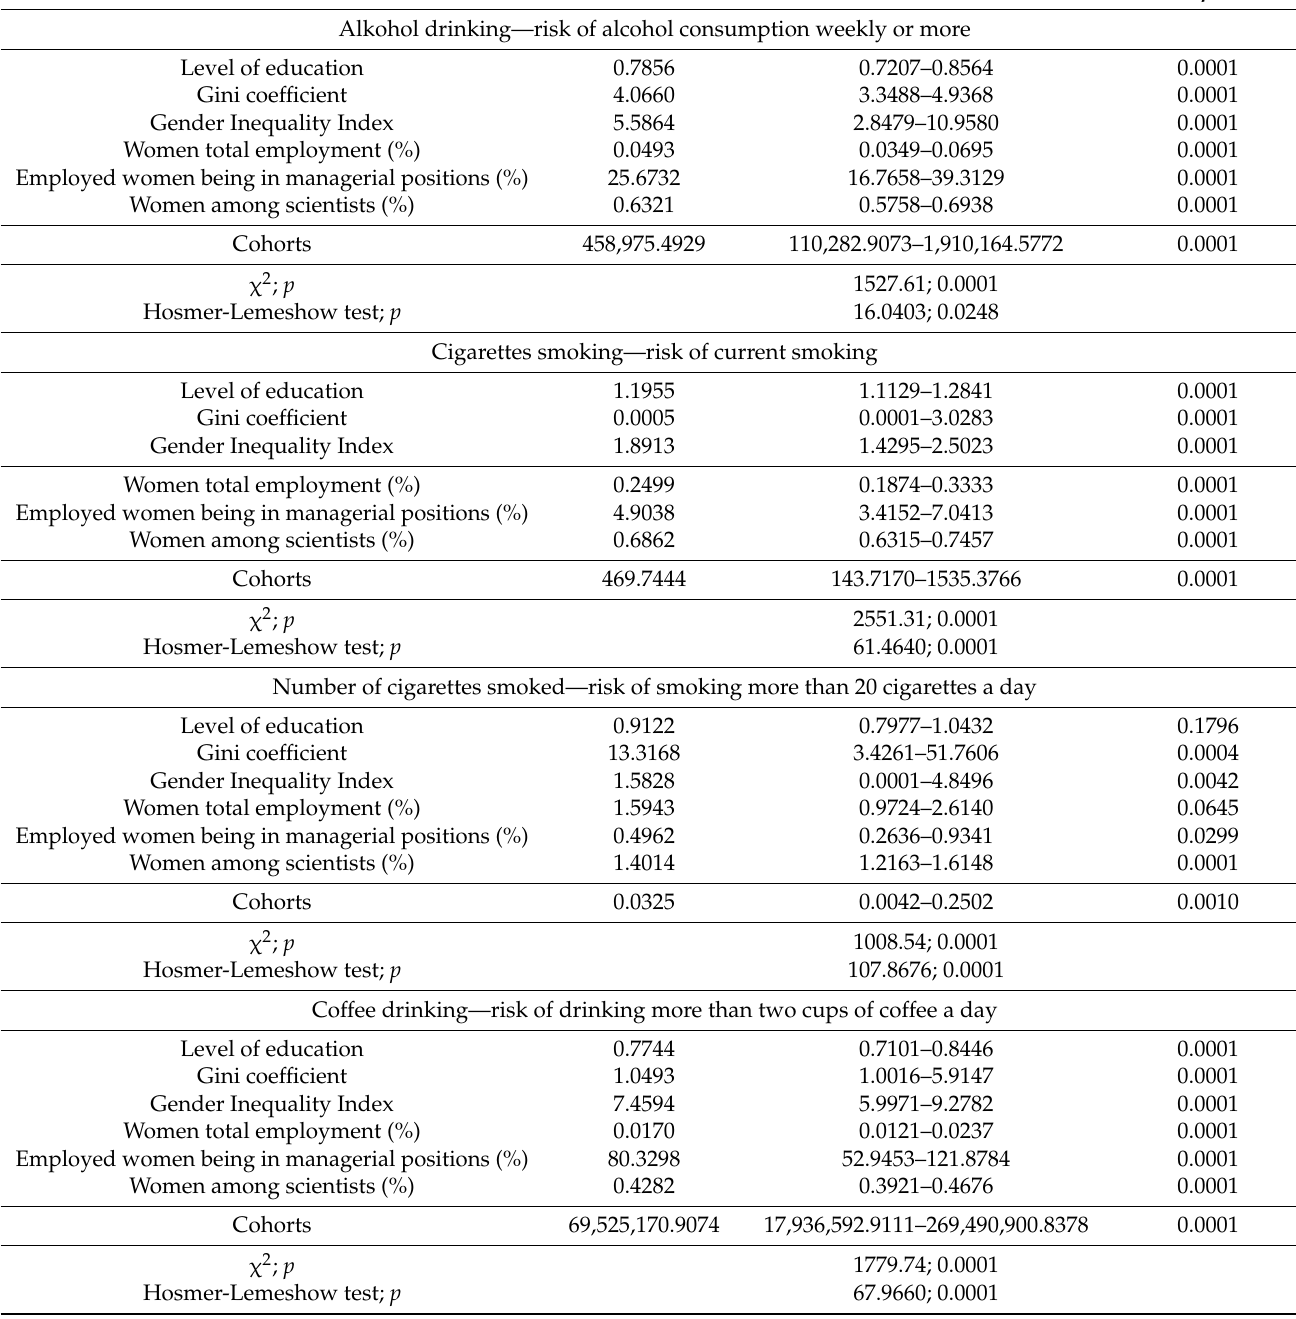
Table 4. Logistic regression analysis results for risk of alcohol consumption weekly or more, risk of current smoking cigarettes, risk of smoking more than 20 cigarettes a day, risk of drinking more than two cups a day, risk of being physically inactive for women’s socioeconomic status and cohorts (OR, 95%CI, p ) and χ 2 and Hosmer-Lemeshow tests results.